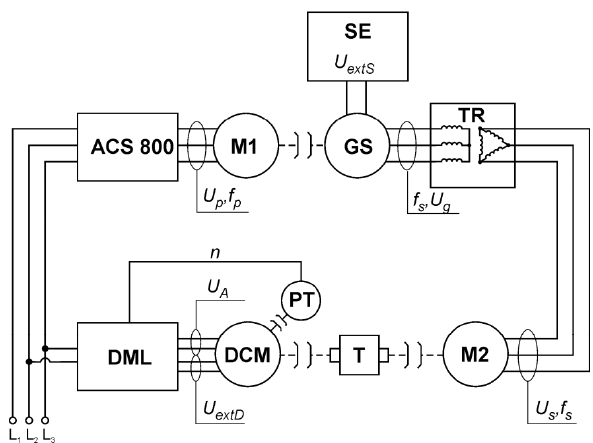
Figure 4. A laboratory stand for testing induction motors M2.